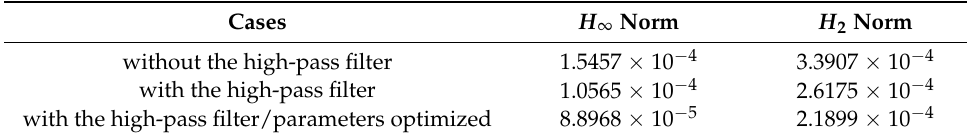
Table 2. Comparison of H ∞ and H 2 norms in three cases.